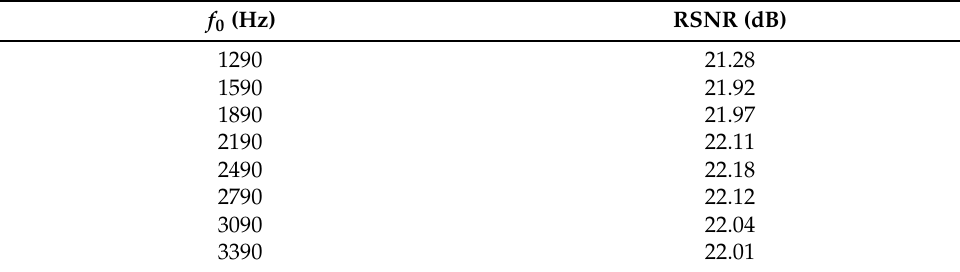
Table 1. Howling frequencies f 0 and RSNR ( N = 32).